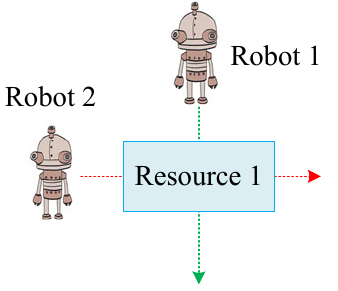
Figure 2. Two robots sharing one